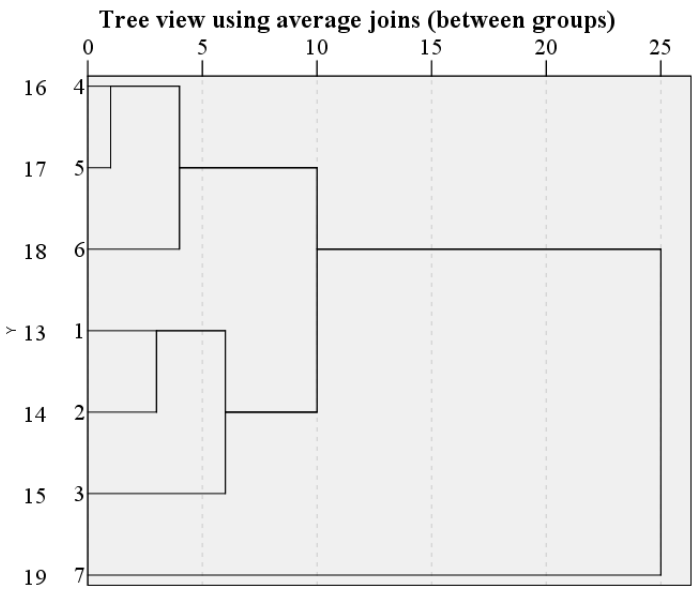
Figure 13. Cluster analysis of Carboniferous sandstone (limestone) facture water system.